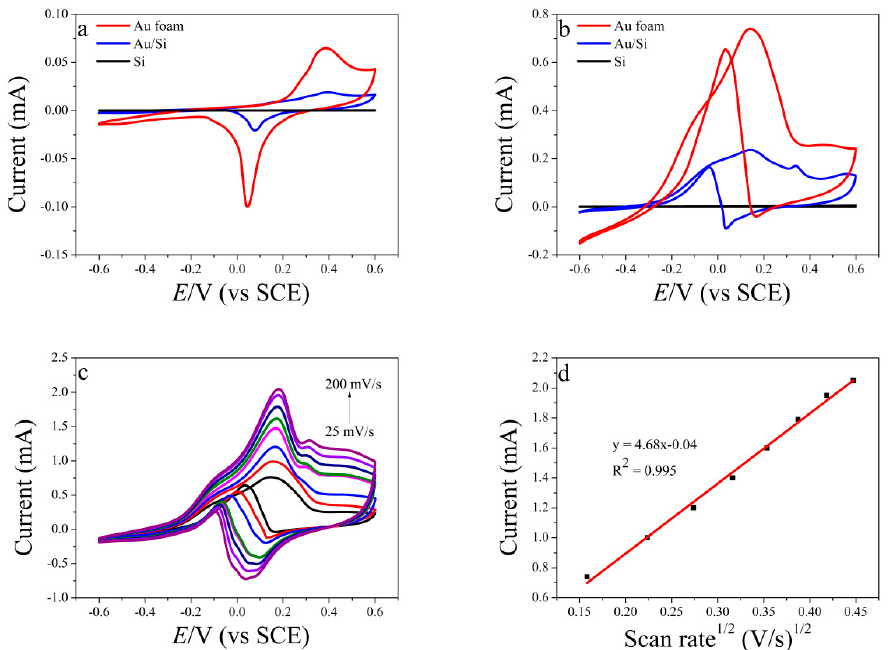
Figure 2. ( a ) Cyclic voltammetry (CV) curves for Au foam, Au/Si, and Si in 0.3 M NaOH at scan rate of 25 mV·s − 1 , ( b ) CV curves for glucose oxidation on Au foam, Au/Si, and Si in 0.3 M NaOH containing 5 mM glucose at scan rate of 25 mV·s − 1 , ( c ) CV curves of Au foam at various scan rates, ( d ) plot of peak current vs. square root of scan rate.